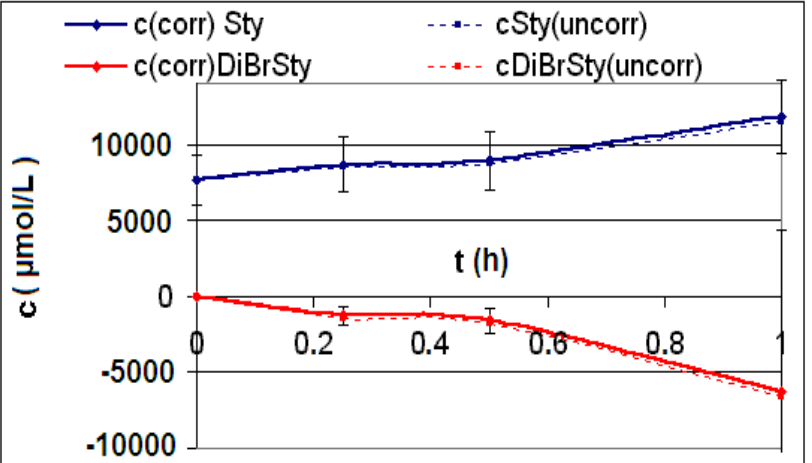
( t ) /c ( t ) corr uncorr